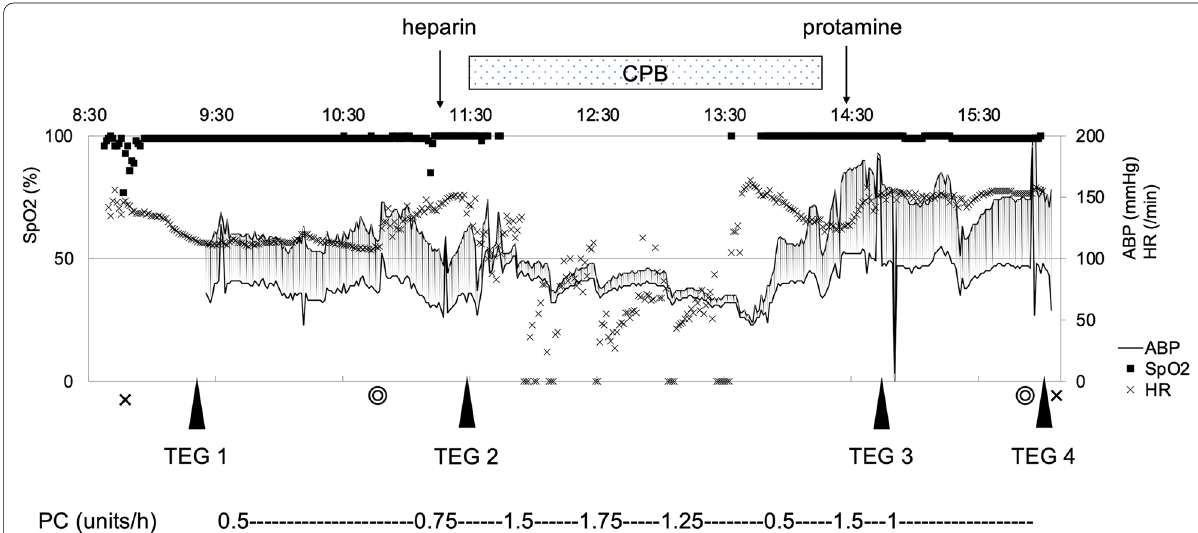
Fig. 1 Anesthetic chart during surgical ventricular septal defect closure. Platelet function measured with thromboelastography (TEG ® 6s) at the beginning of surgery (TEG 1), before CPB start (TEG 2), at the time CPB withdrawal (TEG 3), and after the end of surgery (TEG 4). We continued transfusion with PC during surgery. One PC unit contains rate, PC platelet